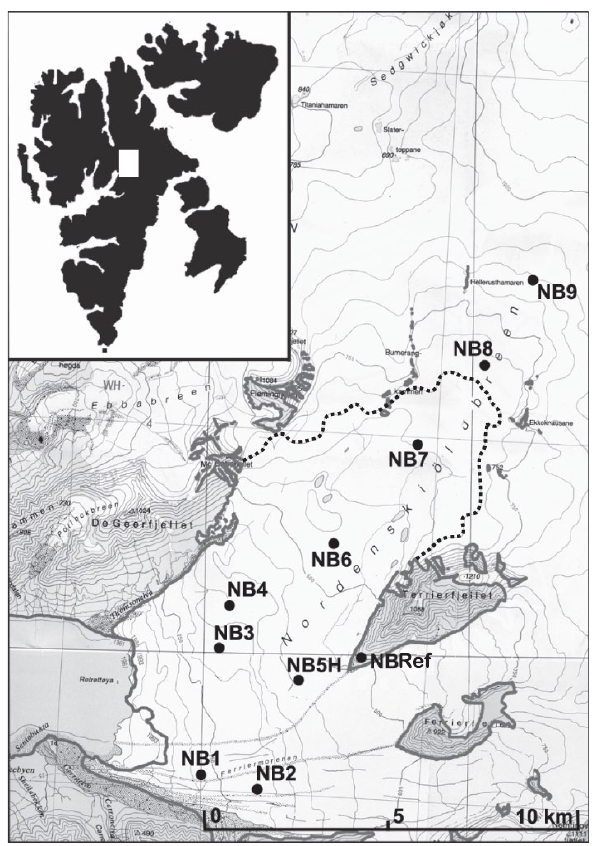
Fig. 2. Map of Nordenski¨oldbreen (NP 1:100000, sheets C7, C8, D7, D8), Svalbard with the locations of the GPS stations (NB1– NB9) and sonic ranger (NB5H) on the glacier, and the reference station on Terrierfjellet (NBRef). The approximate equilibrium line is indicated with a dashed line (Hagen et al., 2003).